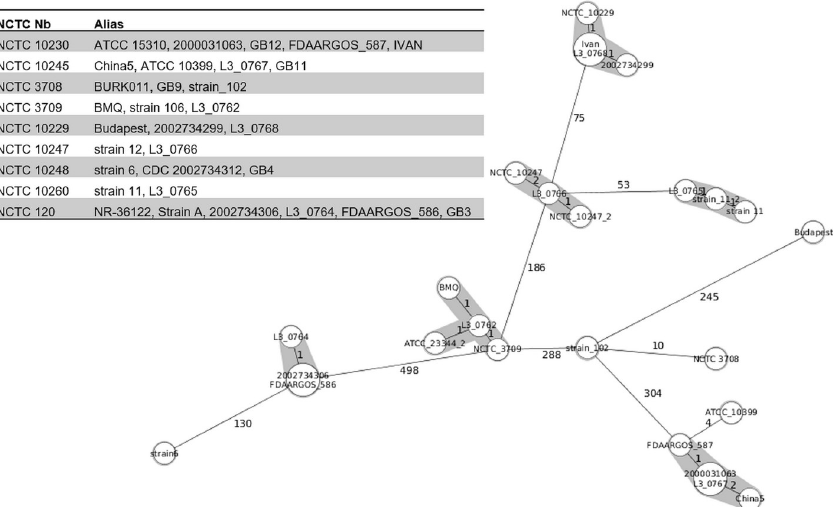
Fig 3. Allelic profiles of NCTC reference strains. The Minimum Spanning Tree was reconstructed on results provided by the cgMLST analysis. Each sequence type is represented by a single node, nodes are connected if they are single locus variants. The size of nodes refers to the number of genomes with identical locus variants. Number along the branches indicate allelic differences. Nodes with less than 3 allelic differences to each other are shaded in grey. Each B . mallei strain is identified by a unique identifier. Strain ATCC_23344T_2 was potentially misclassified as well as strain Budapest.